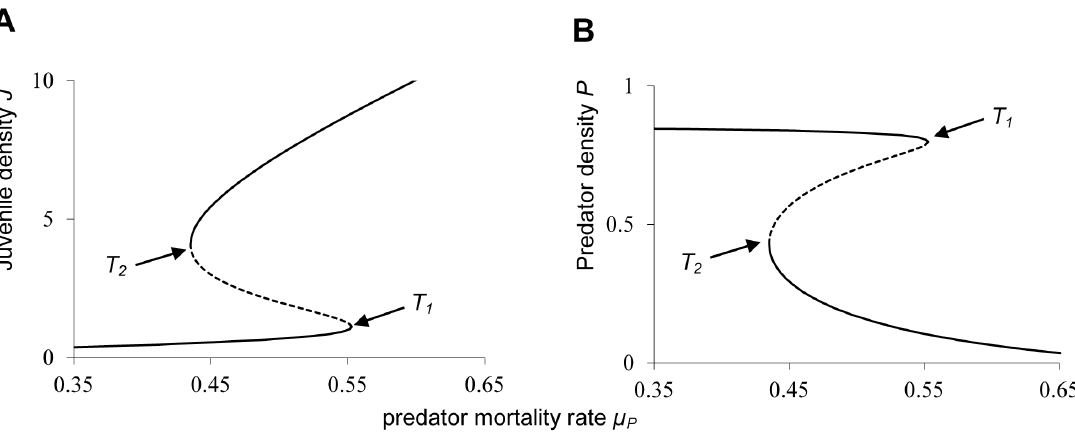
Figure 1. Bistability and catastrophic collapse in a structured predator-prey system. Bifurcation diagram as a function of predator death rate m P . ( A ) Equilibrium juvenile density J, and ( B ) Equilibrium predator density P. The equilibrium curves exhibit a so-called catastrophe fold. Between the bifurcation points T1 ( m P < 0.553) and T2 ( m P < 0.435) the system is bistable (indicated by solid lines), with an intermediate saddle-node equilibrium (indicated by the dashed line) which is unstable. Model parameters are b=1, c=1, m J =0.05, m A =0.1.